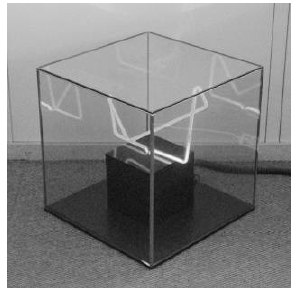
Figure 2: Glass cube in